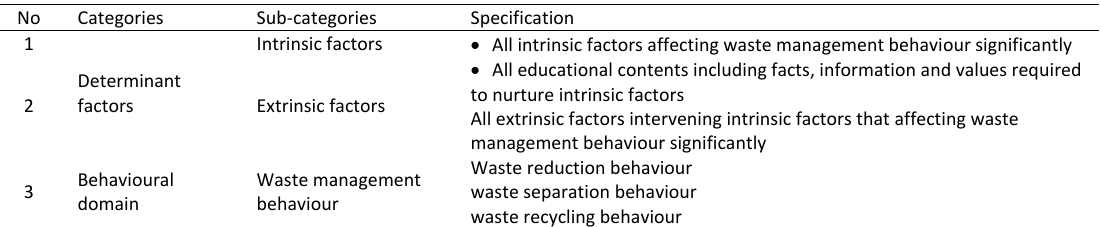
Table 2: The analytical framework to guide the content analysis